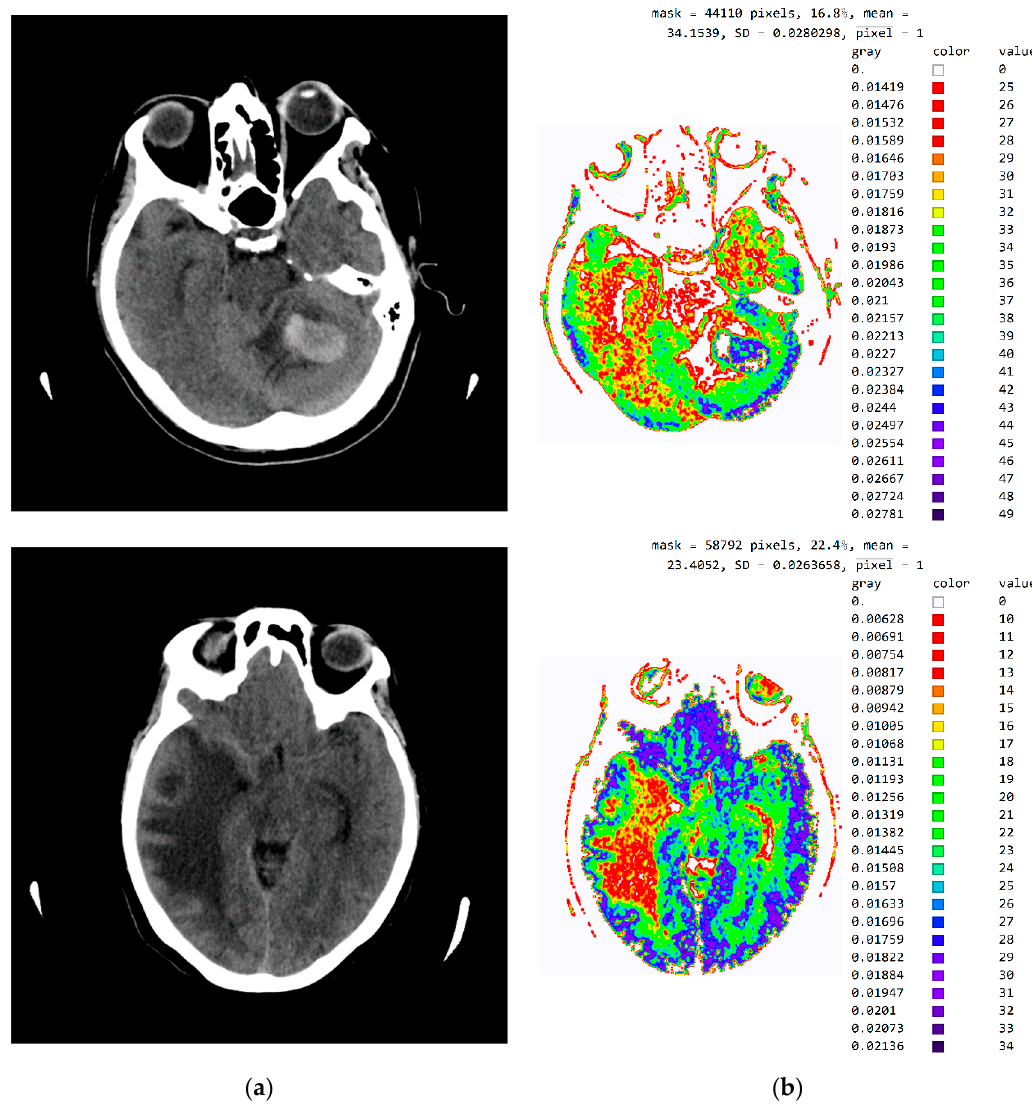
Figure A3. SVMI processing of non-contrast MDCT image. ( a ) Non-contrast MDCT image and ( b ) Smart Visualization of Medical Images SVMI.